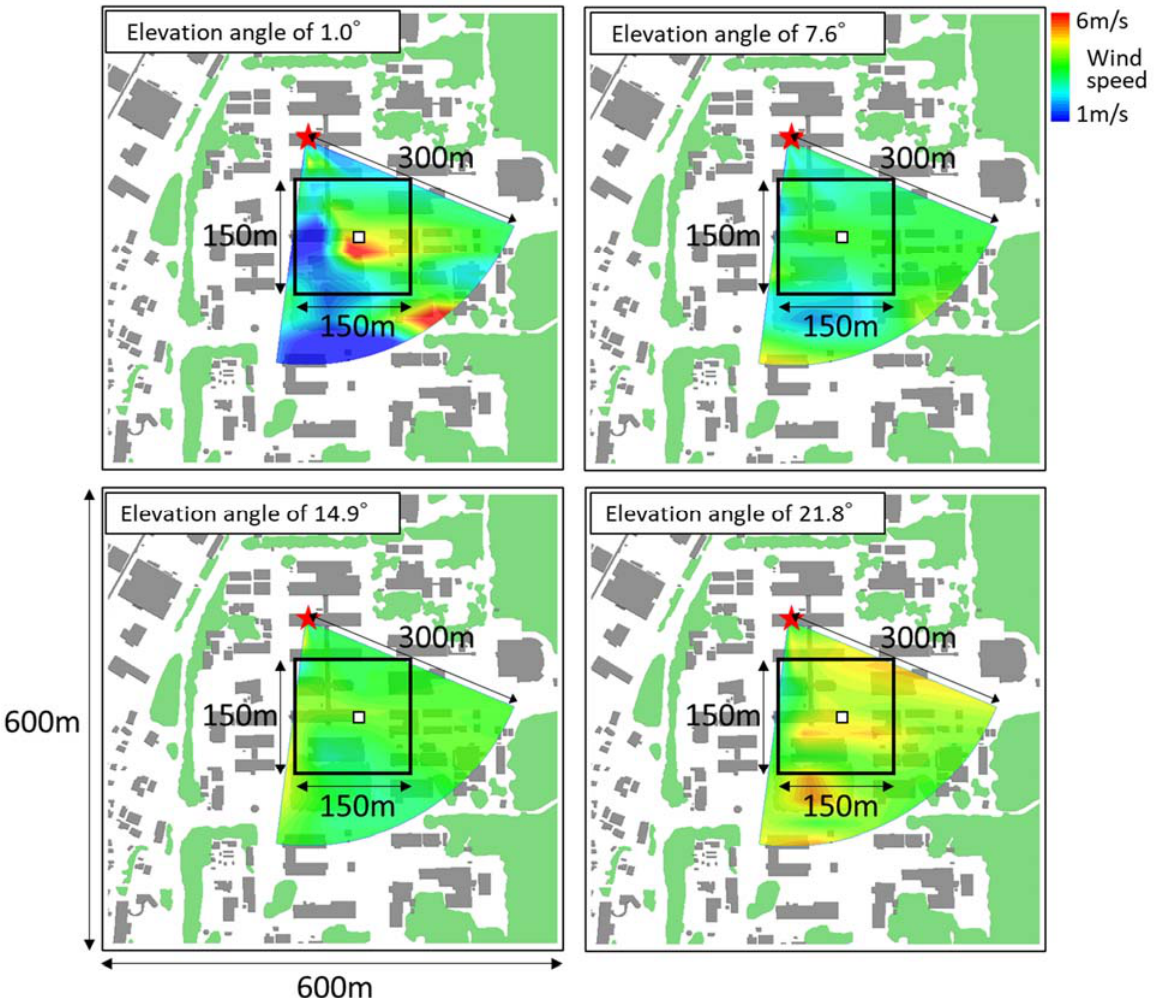
Figure 2. Spatial distributions of radial wind speeds at elevation angles of 1.0 ◦ , 7.6 ◦ , 14.9 ◦ , and 21.8 ◦ on 1122 JST 26 November 2020. The square indicates the computational domain used for calculating plume dispersion. The symbols are the same as in Figure 1. The gray and green areas indicate buildings and tree canopy, respectively. The gray and green areas are buildings and tree canopy, respectively.